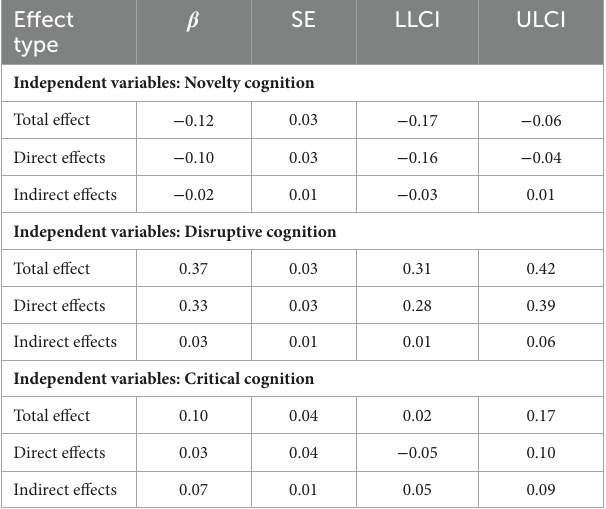
TABLE 4 Bootstrap test results of mediation effects.